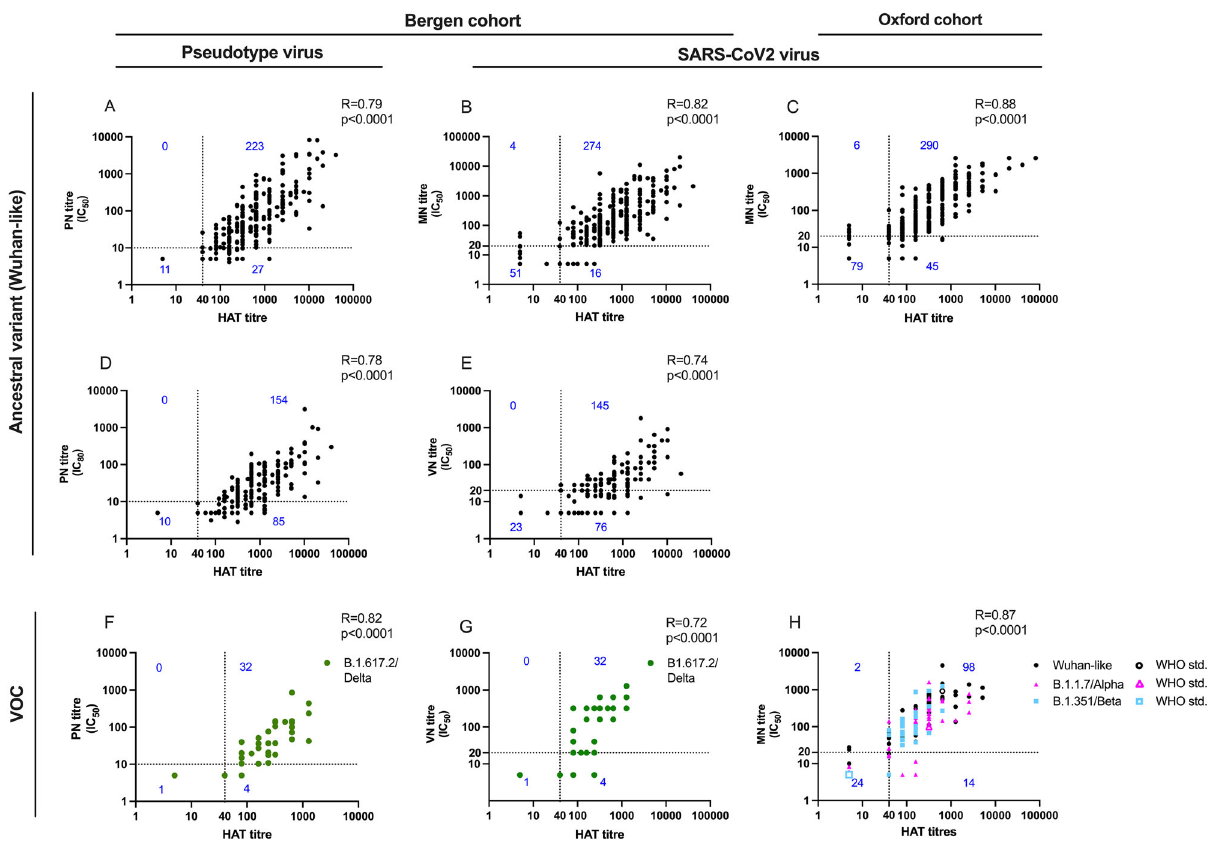
Fig. 1 The correlation between haemagglutination test and SARS-CoV-2 neutralising antibodies. Correlation of endpoint haemagglutination test (HAT) titres with neutralising antibody titres. In a cohort of infected individuals from the fi rst (Wuhan-like) and delta pandemic waves (diagnosis by PCR from nasopharyngeal swabs or serology in Bergen, Norway) ( a – b , d – g ), Wuhan-like neutralising antibodies were measured using the pseudotype (PN) neutralisation assay at 50% (PN 50 ) ( a ) (R = 0.79, 95% con fi dence interval (CI): 0.73 – 0.83) and 80% (PN 80 ) ( d ) (R = 0.78, 95% CI: 0.72 – 0.82) inhibition of pseudotype virus infectivity, the microneutralisation (MN) 50% inhibitory concentration (IC 50 ) ( b ) (R = 0.82, 95% CI: 0.78 – 0.85) and virus neutralization (VN) 100% inhibition of cytopathic effect ( e ) (R = 0.74, 95% CI: 0.68 – 0.80) assays. Delta-like neutralising antibodies were measured in the PN assay at PN 50 ( f ) (R = 0.82, 95%